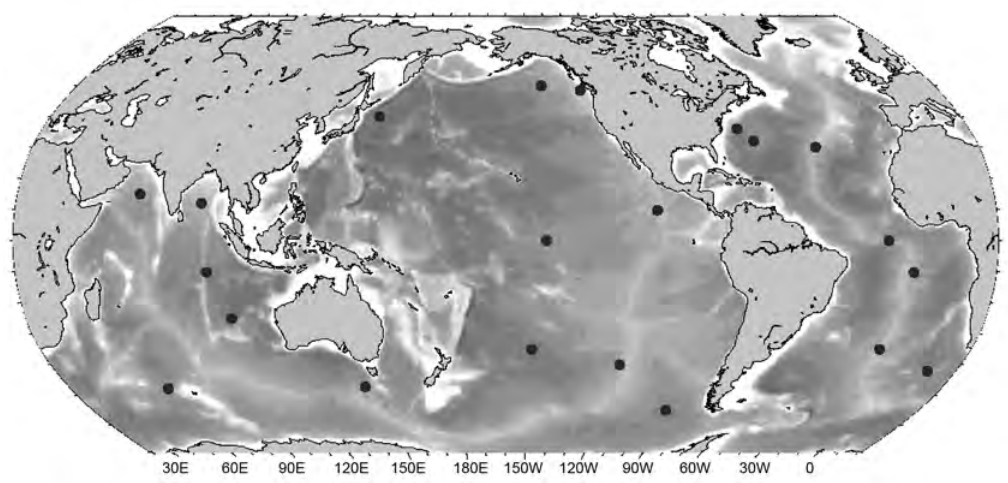
Fig. 5. Location of proposed OOI global observatory network sites (NRC,